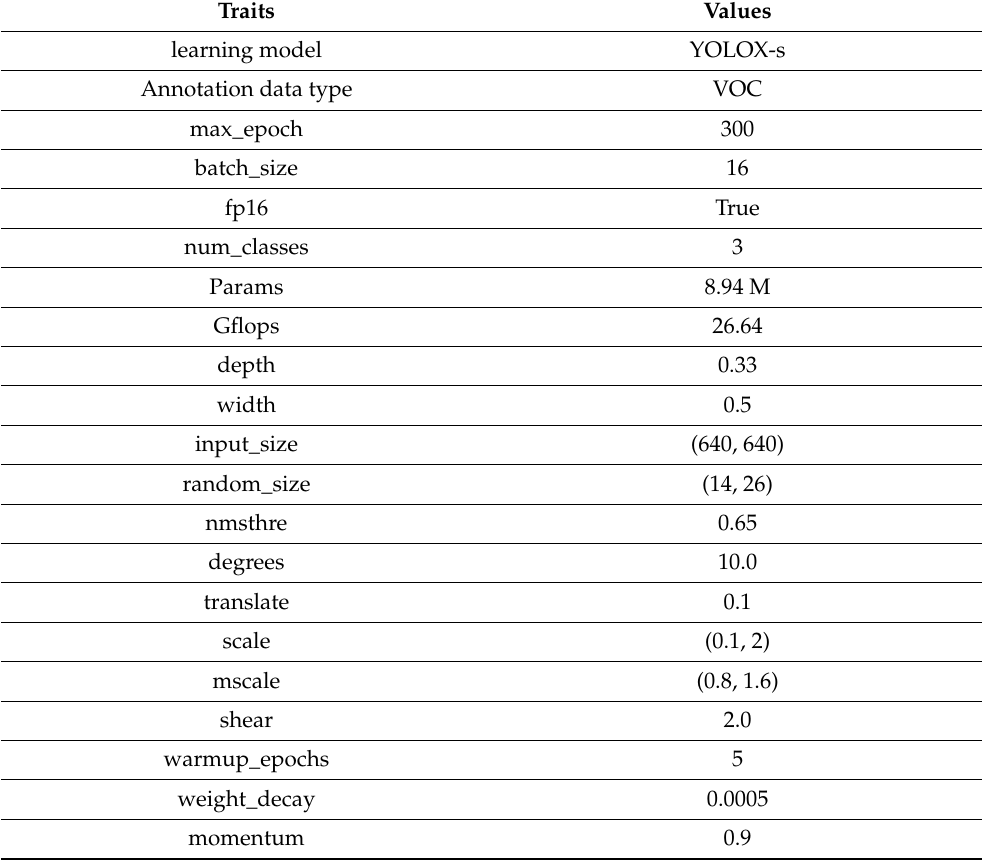
Table 6. Crucial traits in